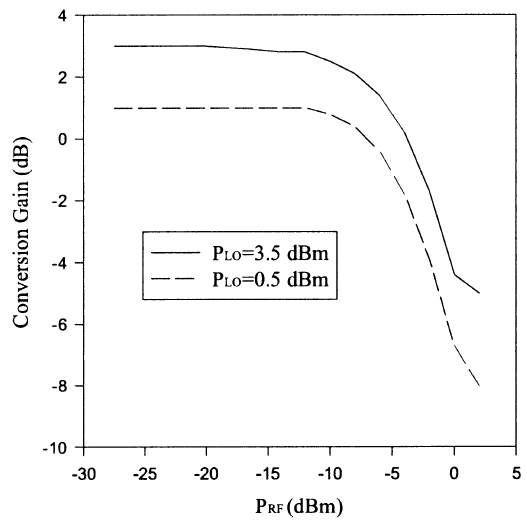
FIGURE 17 Conversion gain vs. the P RF .